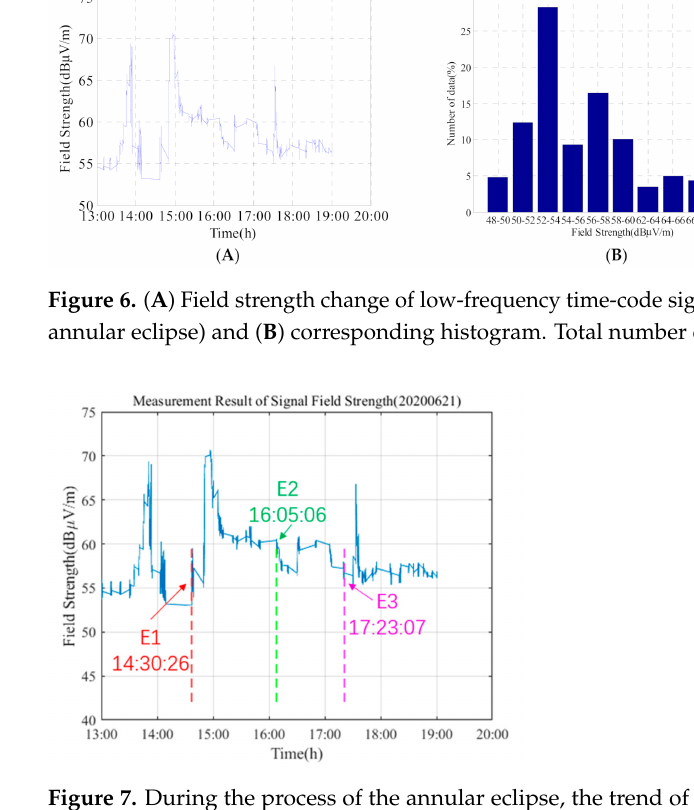
Figure 7. During the process of the annular eclipse, the trend of the field strength variation of the low-frequency time-code signals was observed. The symbols E1, E2, and E3, respectively correspond to the times of first contact, mid totality, and last